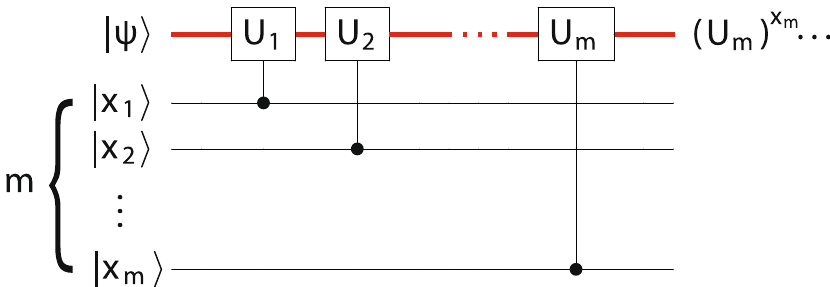
Figure 4. A circuit with m distinct controlled unitaries in succession. The red upper line is an n -qubit SES register. When the m ancilla are in a computational basis state | x 1 x 2 · · · x m � with x i ∈ { 0, 1 } , the action on